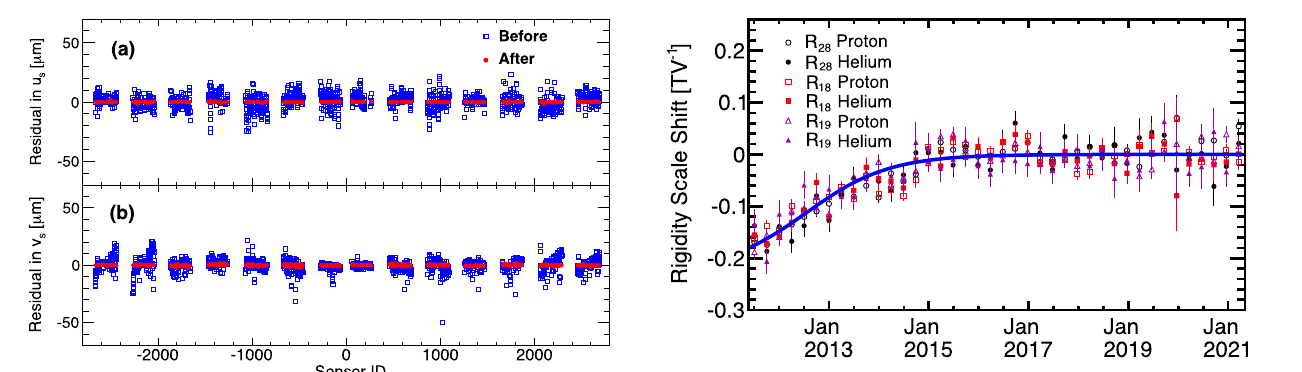
Fig. 26 The residual biases of the individual sensors of the inner tracker in a the u s direction and b the v s direction before (open squares) andafter(fullcircles)thestaticalignmentforaselectedcosmic-raypro- ton sample with rigidity R > 30 GV based on 10 years of AMS data. A circle or square represents a residual bias of each sensor. The circles or squares of a common group are the sensors from the same half of a tracker layer